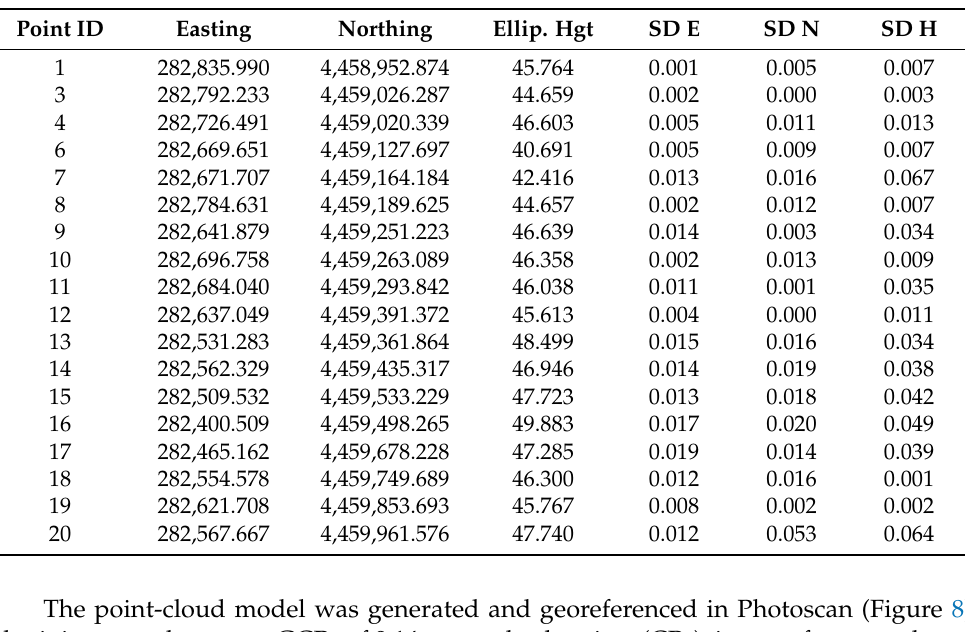
point-cloud model was georeferenced through the identification of ground control points (GCPs) obtained with GNSS kinematic survey in post-processing with Leica GNSS GS12 geodetic receivers (dual frequency). The GNSS data processing was conducted using the permanent station of Melendugno (MELE) as a base station, belonging to the Italpos HxGN SmartNet Network (Italy). The spatial coordinates (east, north, altitude) of the 20 GCPs and the relative standard deviation (SD) values are reported in Table 1. Table 1. Points coordinates in UTM34N-ETRF2000 and SD values (values in metres).